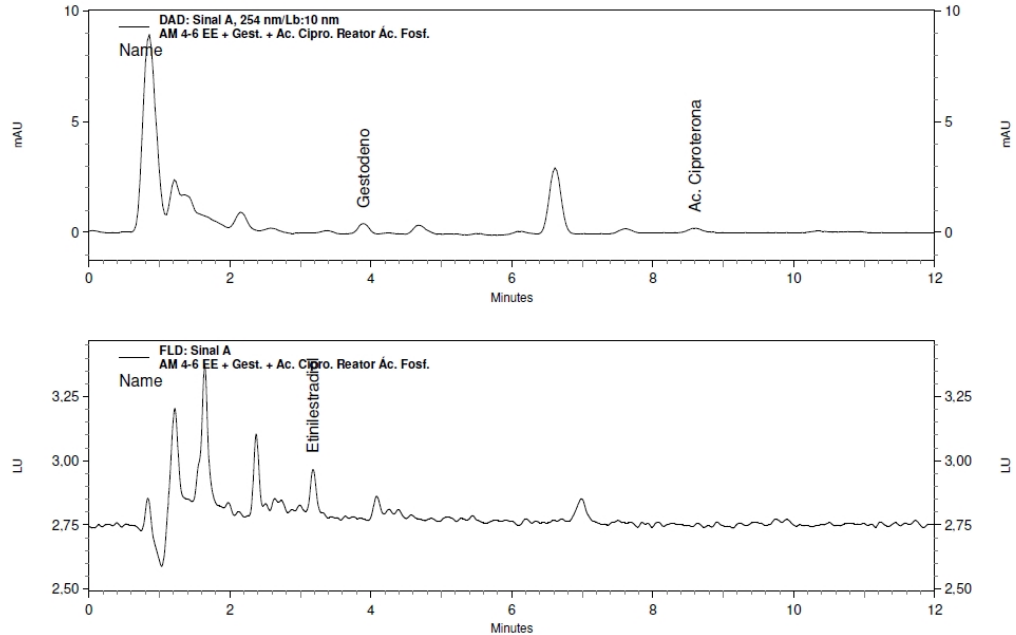
Figure 3 - Chromatograms from solutions of Gestodene + Ethinylestradiol + Cyproterone acetate after removal by CHT. DAD Detection at the top and Fluorescence at the